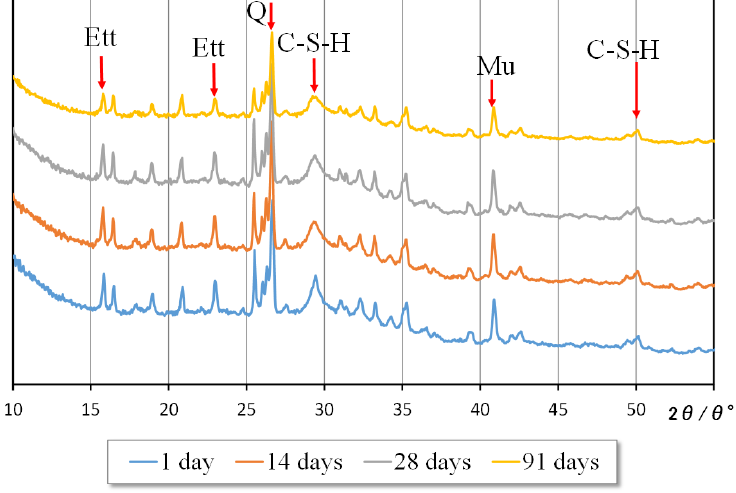
Figure 5. Results of powder X-ray diffraction.